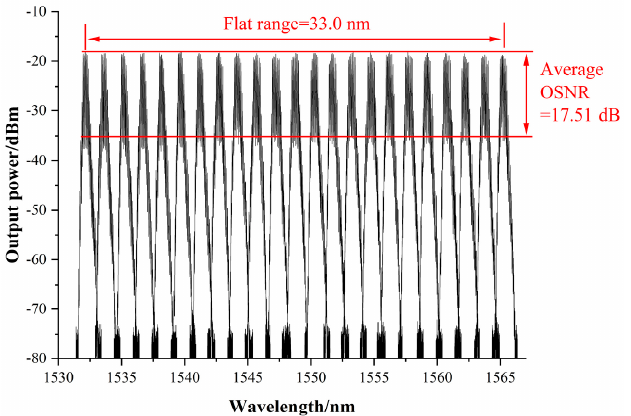
Figure 6. Flat output spectra of different TLS wavelengths in the 33 nm range.